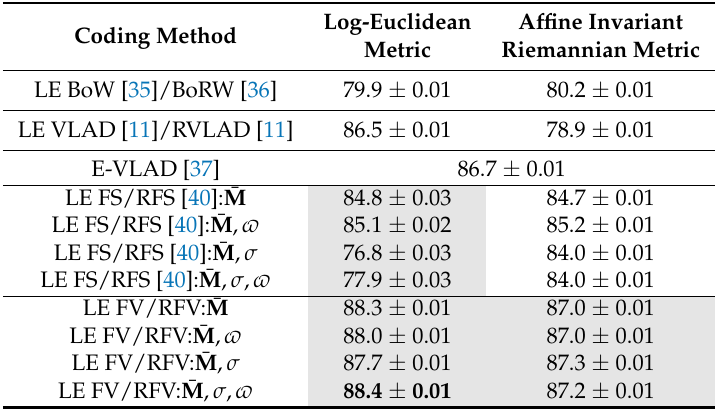
Table 6. Classification results on the USPtex database (191 classes).